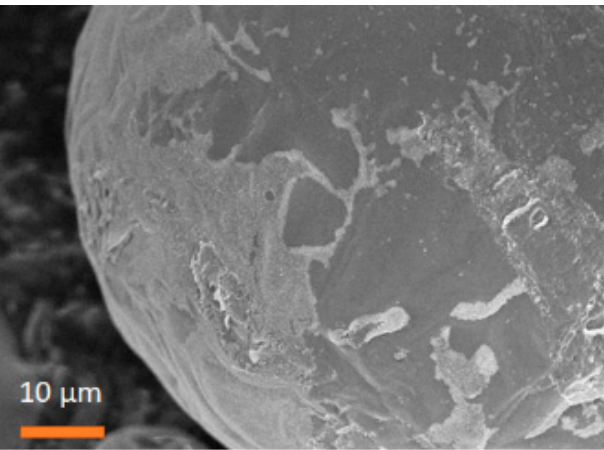
Figure 5. SEM image of Sample 7.